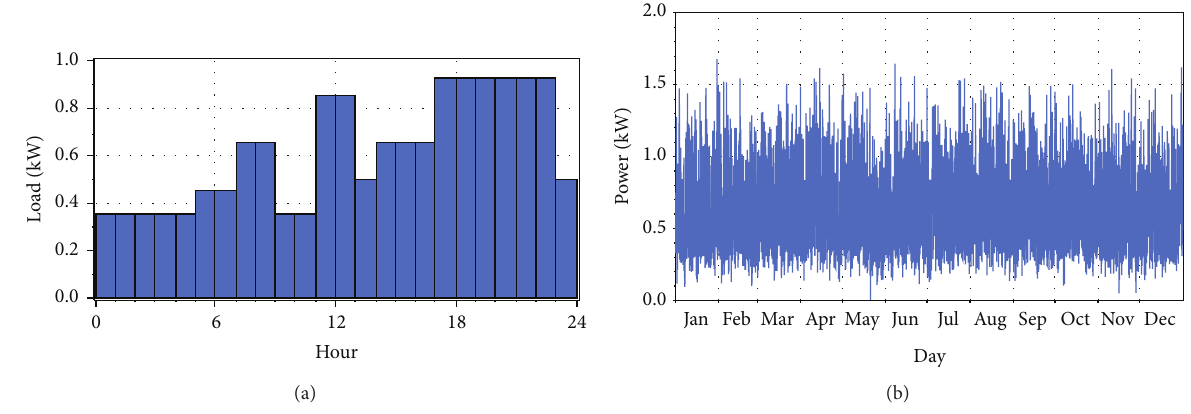
Figure 9: Electrical load. (a) Daily profile. (b) Yearly